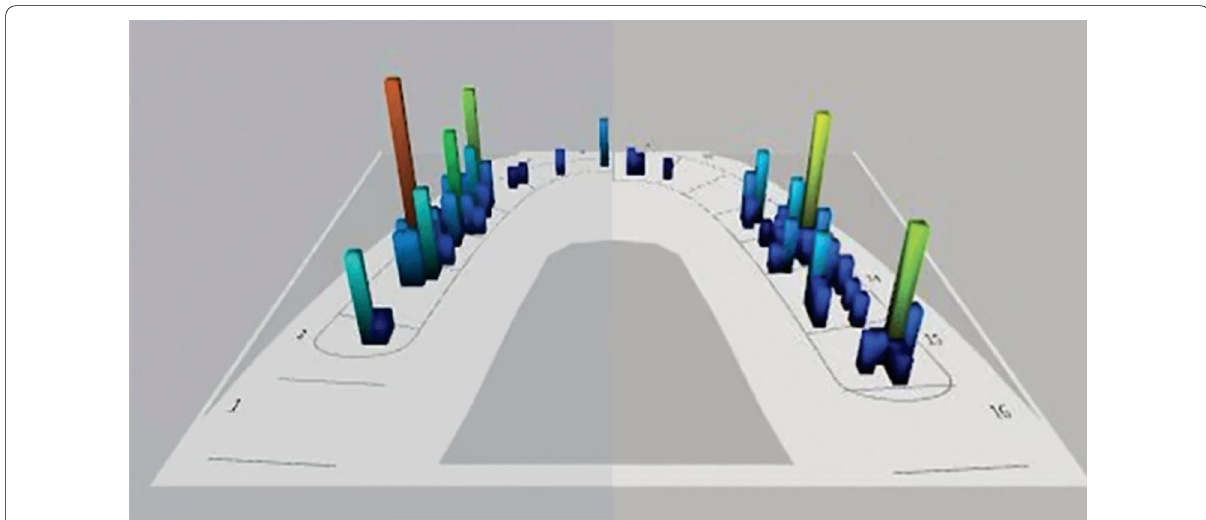
Fig. 3 T-Scan record after denture relining, the right side shows absence of high intensity force columns and more favorable force distribution pattern, while the left side shows premature contacts at particular areas, indicated by red columns (representing higher intensity